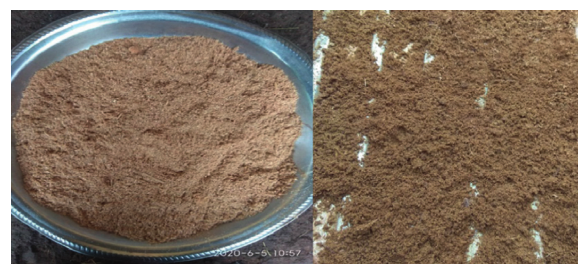
Figure 1: Sieved wood